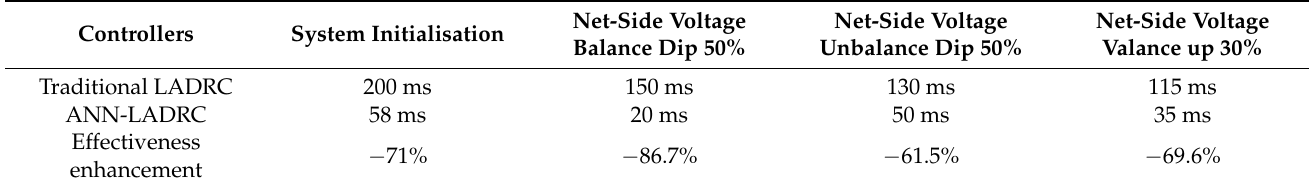
Table 2. DC bus voltage repair time with different